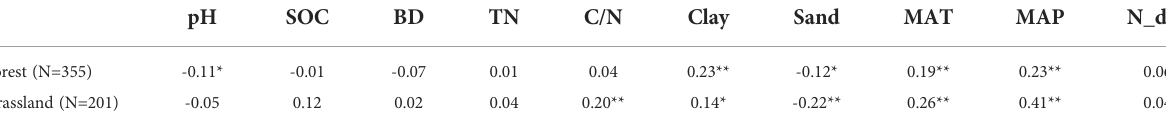
TABLE 2 Spearman correlation coef fi cient (R) between N 2 O emissions and edaphic, climatic variables. pH SOC BD TN C/N